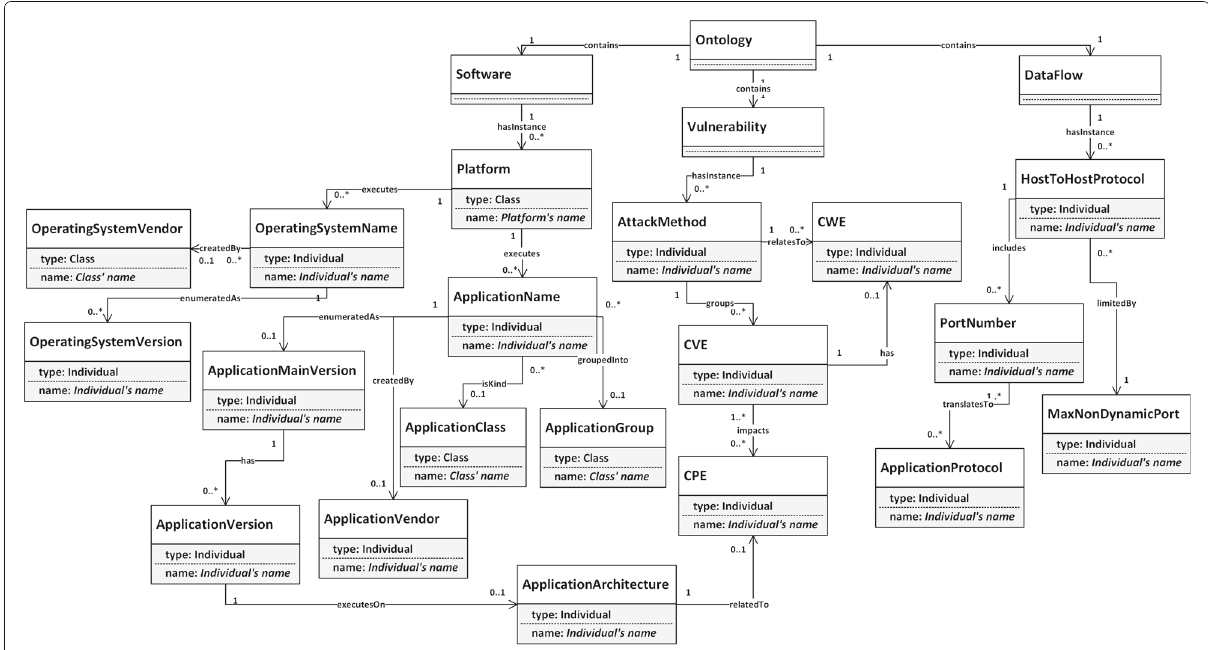
Fig. 9 Database schema created from merged content patterns